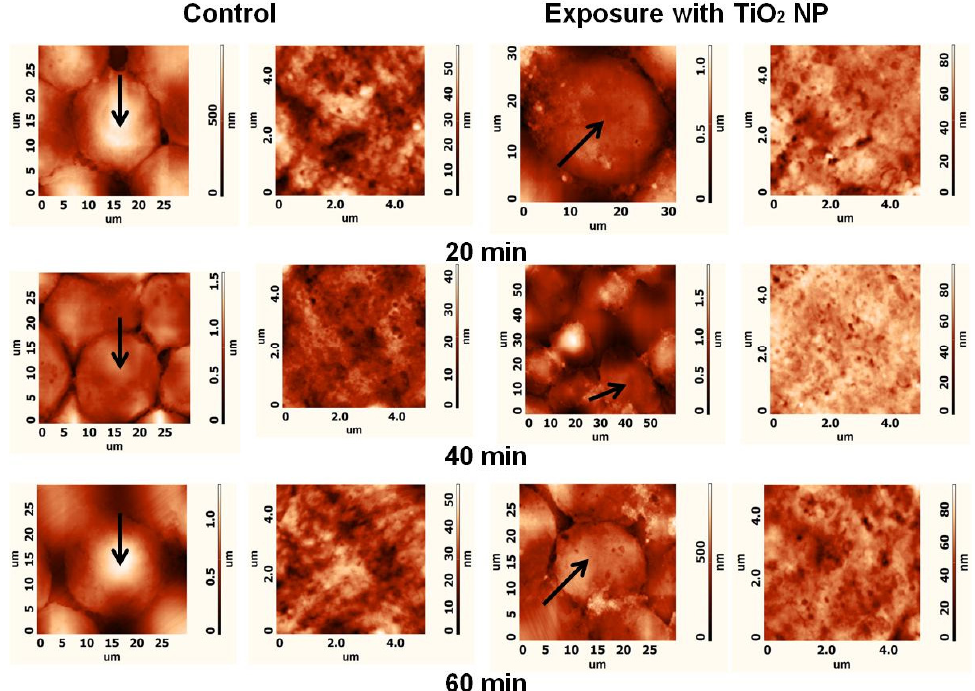
Figure 6. Representative AFM images of CHO control cells and cells after 20, 40, or 60 min exposure to TiO 2 ; the first and the second columns show images of the topography of the whole cell and cell plasma membrane ultrastructure (5 × 5 µ m), respectively, in the cases of the control; the third and the fourth columns show images of the topography of the whole cell and cell plasma membrane ultrastructure (5 × 5 µ m), respectively, after exposure to TiO 2 -NPs. Investigated cells are indicated by arrows in the whole-cell images of the topography.